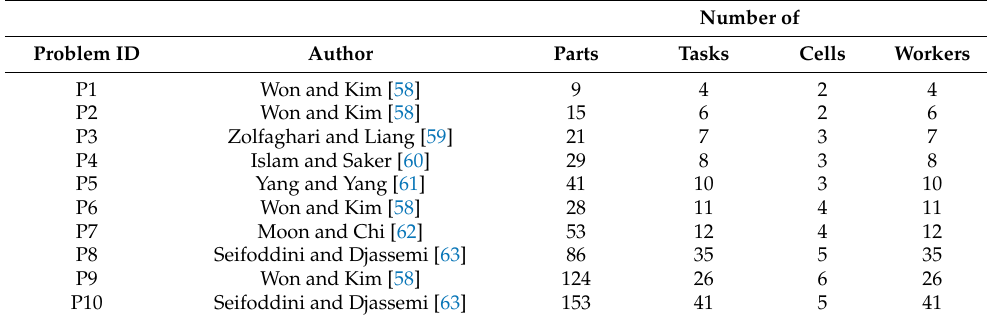
Table 13. Problem benchmarks.